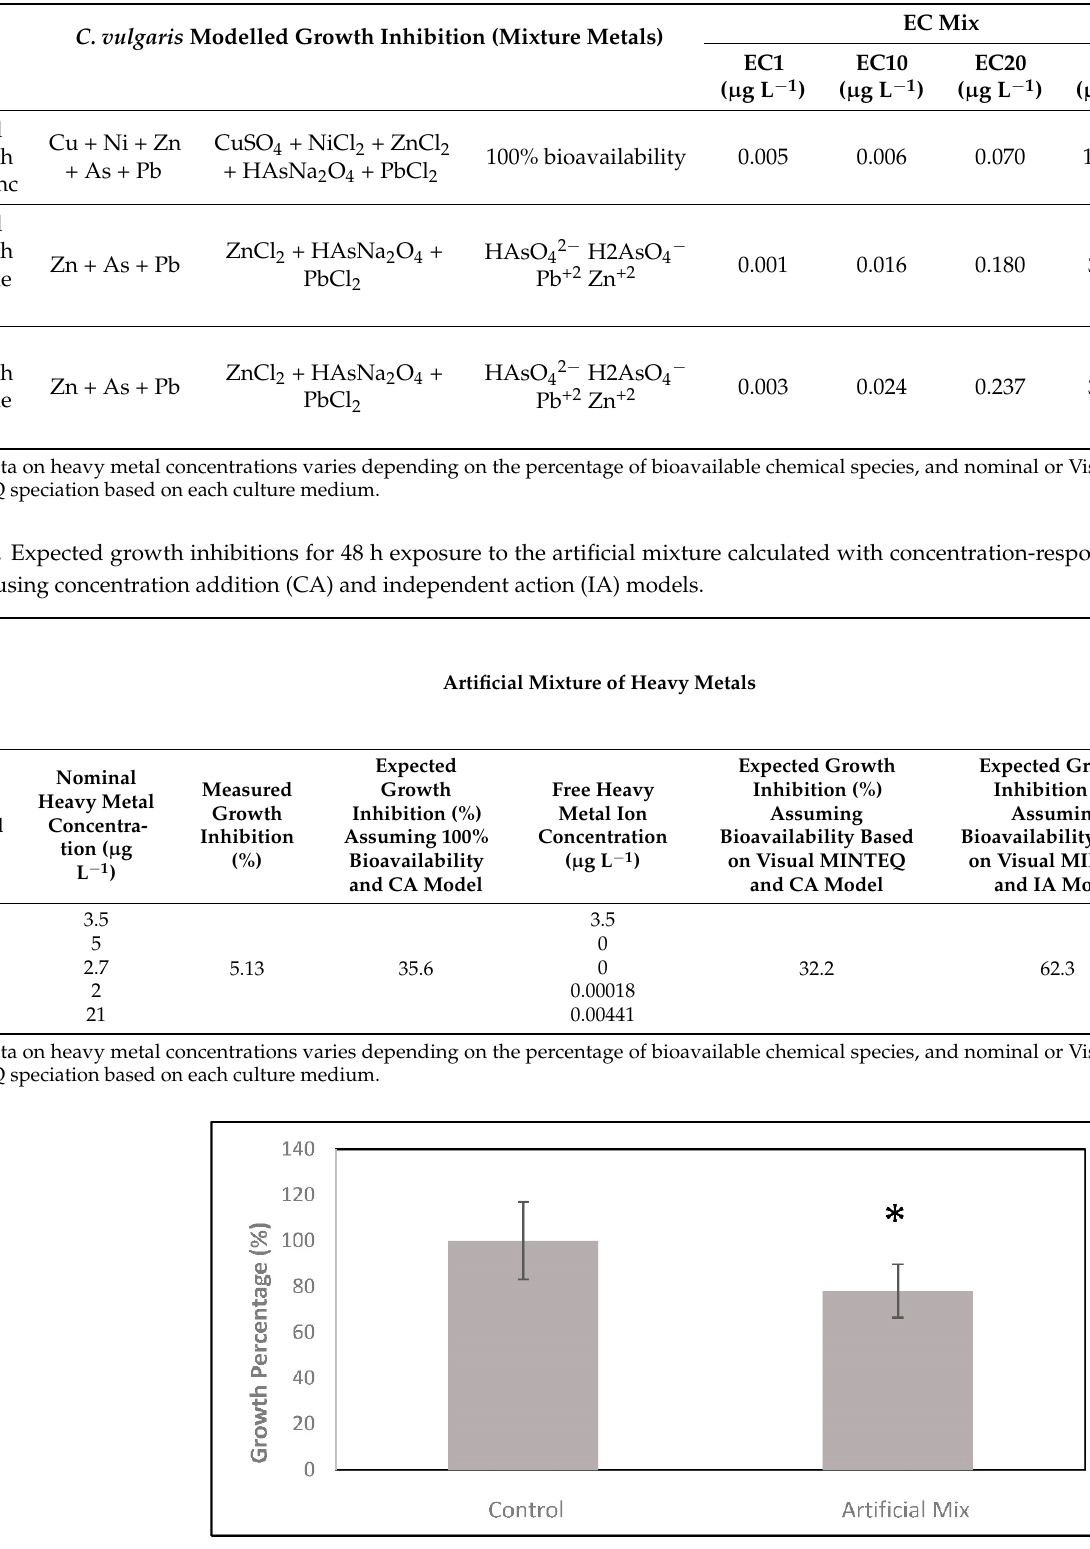
Table 4. Selected expected effective concentrations (ECx) for 48 h exposure to heavy metals mixture for growth inhibition calculated with concentration-response curves using concentration addition (CA) and independent action (IA) models.